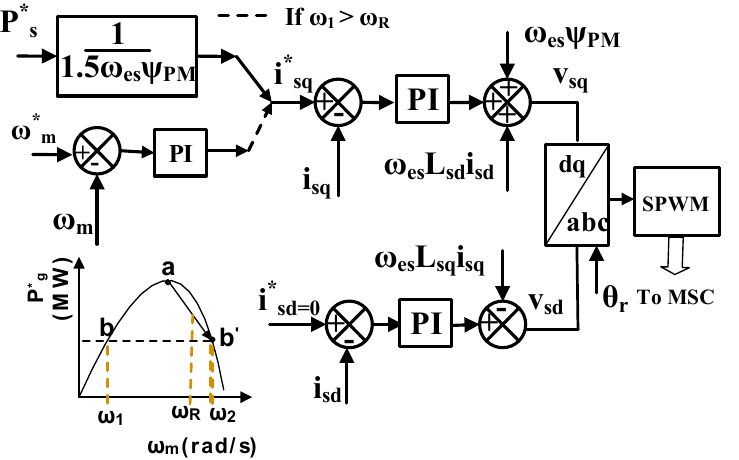
Figure 3. Modified MSC controller. ɷ m —rotor speed; ɷ R —rated speed; ɷ 1 is the speed at P 1 which is lesser than ɷ R ; ɷ 2 is the speed at the same power P 1 which is greater than ɷ R.